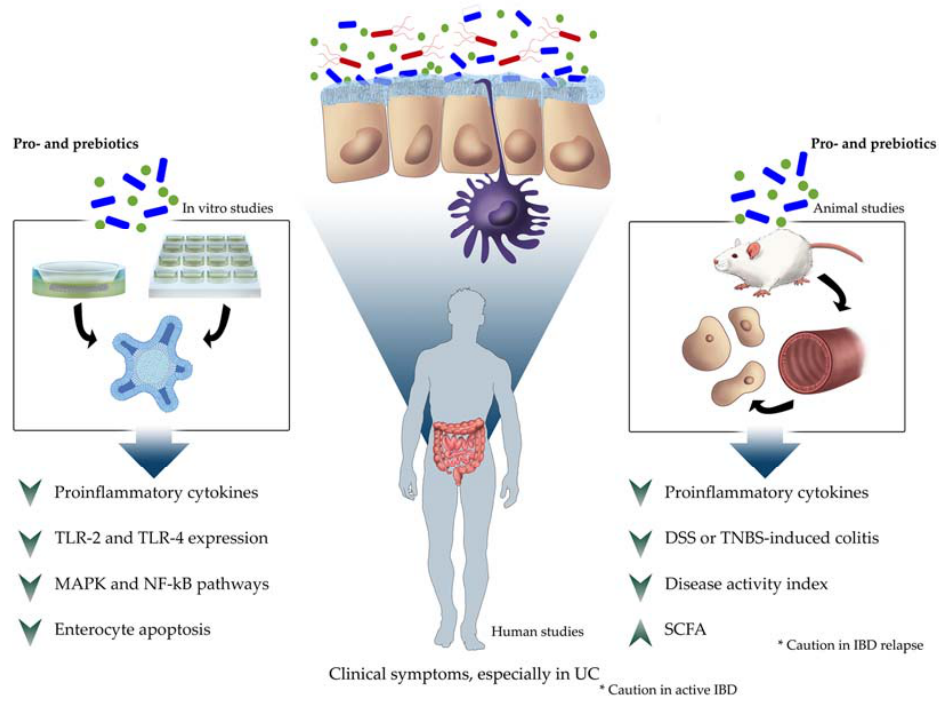
Figure 1. Summary of probiotic anti ‐ inflammatory effects in intestinal chronic diseases in different scientific approaches. DSS, dextran sulfate sodium; IBD, inflammatory bowel disease; MAPK, mitogen ‐ activated protein kinase; NF ‐κ B, nuclear factor kappa ‐ B; SCFA, short ‐ chain fatty acids; TNBS, 2,4,6 trinitrobenzenesulfonic acid; TLR, toll ‐ like receptor; UC, ulcerative colitis.